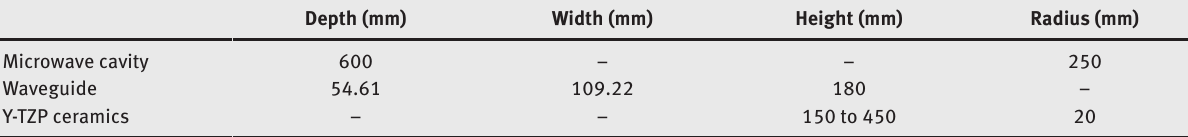
Table 1: Global model parameters.